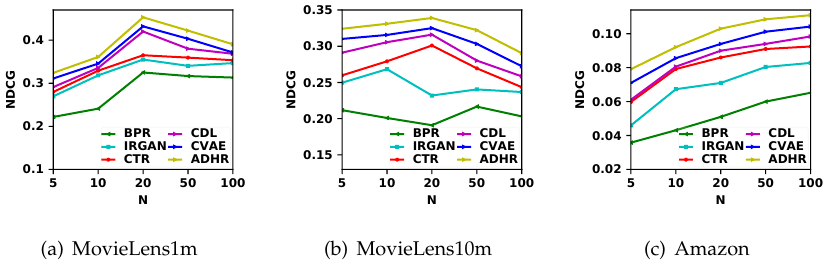
Figure 2. Warm-start recommendation performance w.r.t. different values of N.